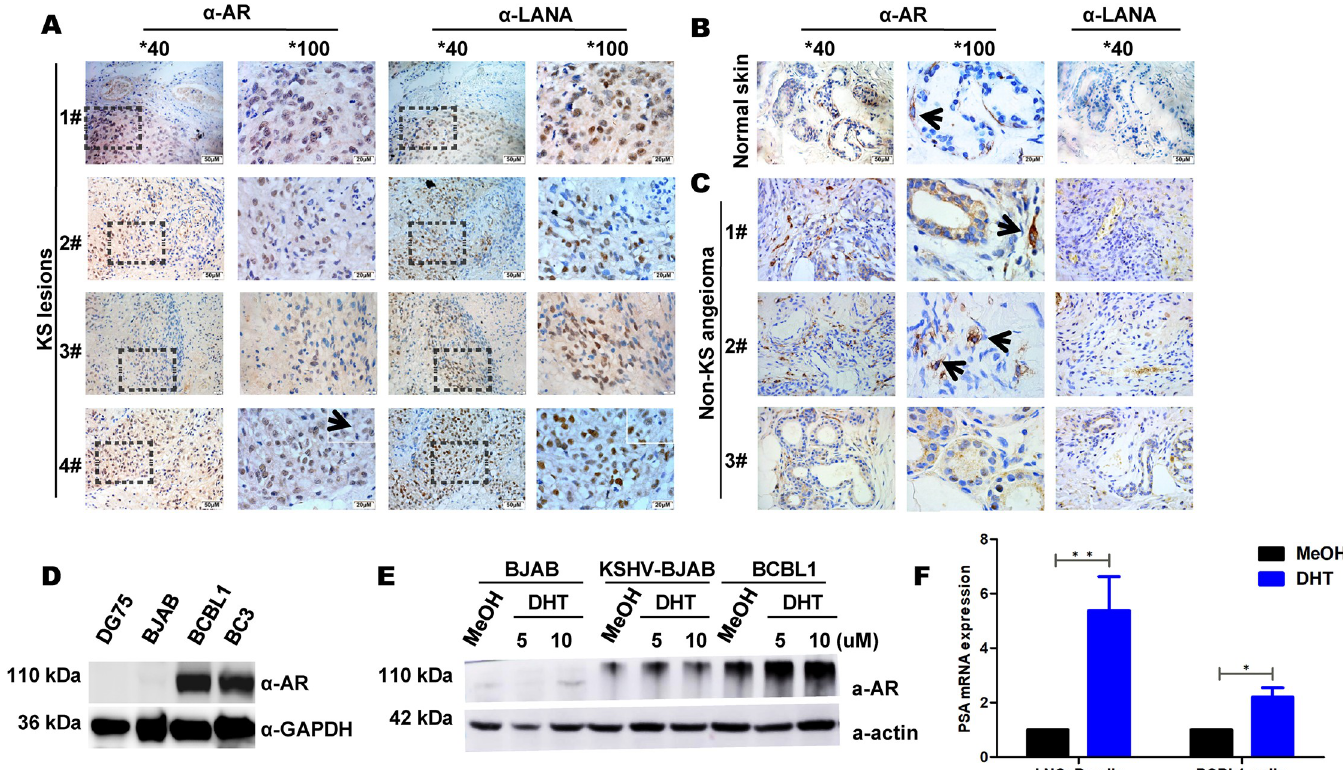
Fig 1. AR is highly expressed in KS tissues and co-localized with the viral oncoprotein of LANA. Expression of AR and LANA was detected in 12 KS tissues (A), one normal skin tissue sample (B), and 6 non-KS angioma tissues (C) by immunohistochemical analysis. ( A) Extensive distribution of AR predominantly in the nuclei of spindle cells was detected in KS lesions. Spindle cells were characterized by nuclear staining of LANA. Boxes indicate the same regions from which the cells were positively immunostained by AR and LANA. (B) Expression of AR was restricted to the area around the hair follicle of the dermis in normal skin tissue. No LANA staining was seen in the specimen. (C) AR was cytoplasmically expressed in the basal cells of non-KS angioma tissues at a very low level. No LANA staining was found in these tissues. Arrows indicate cytoplasmic AR expression in the cells. Four and three representative images of KS and non-KS angioma tissues are shown, respectively. Original magnification is × 40 and × 100, and their scale bar is 50 μ m and 20 μ m, respectively. (D) AR was abundantly expressed in KSHV-positive B cells of BCBL1 and BC3, but not in the KSHV-negative DG75 and BJAB. The cells were cultured in a steroid-stripped medium and subjected to immunoblot detection. (E) Strong potency of DHT treatment to induce the expression of AR in a dose-dependent manner in KSHV-positive B cells. Cells were counted and cultured in a steroid-stripped medium for 24 h, followed by DHT treatment at indicated concentrations for 48 h before cell harvesting. (F) Increased AR expression by DHT treatment functions by transactivating the classical target gene of prostate-specific antigen (PSA) in BCBL1 cells. BCBL1 cells and androgen-sensitive cells of LNCaP were treated with 10 μ M DHT or solvent control in a steroid-stripped medium for 48 h, followed by detection of PSA and actin by RT-qPCR. Each reaction was repeated in, at least, triplicate.